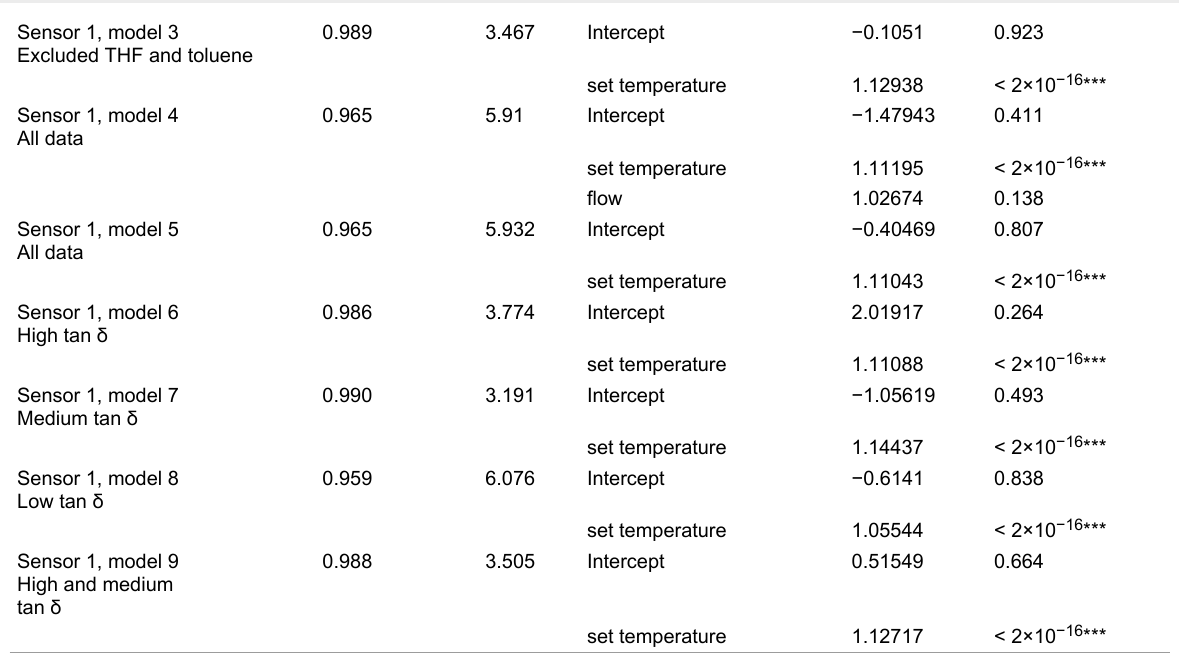
Table 2: Linear multiple regression models for IR sensor 1. (continued) Sensor 1, model 3 Excluded THF and toluene